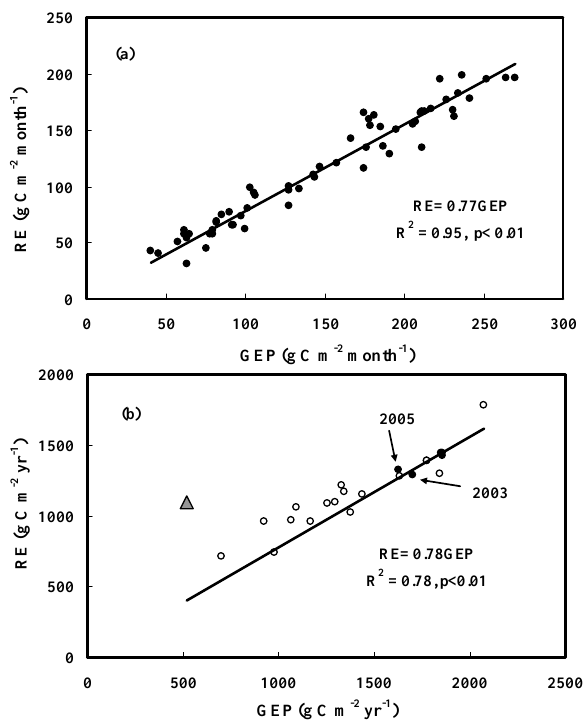
Fig. 6. The dependence of (a) monthly and (b) yearly ecosystem respiration (RE) on gross ecosystem photosynthesis (GEP) during 2003 to 2007 at Qianyanzhou site. The linear regression lines were shown for the monthly and yearly dataset of Qianyanzhou site. The dataset cited in Table 3 are shown as blank circles and triangle (clearcut) for comparison.